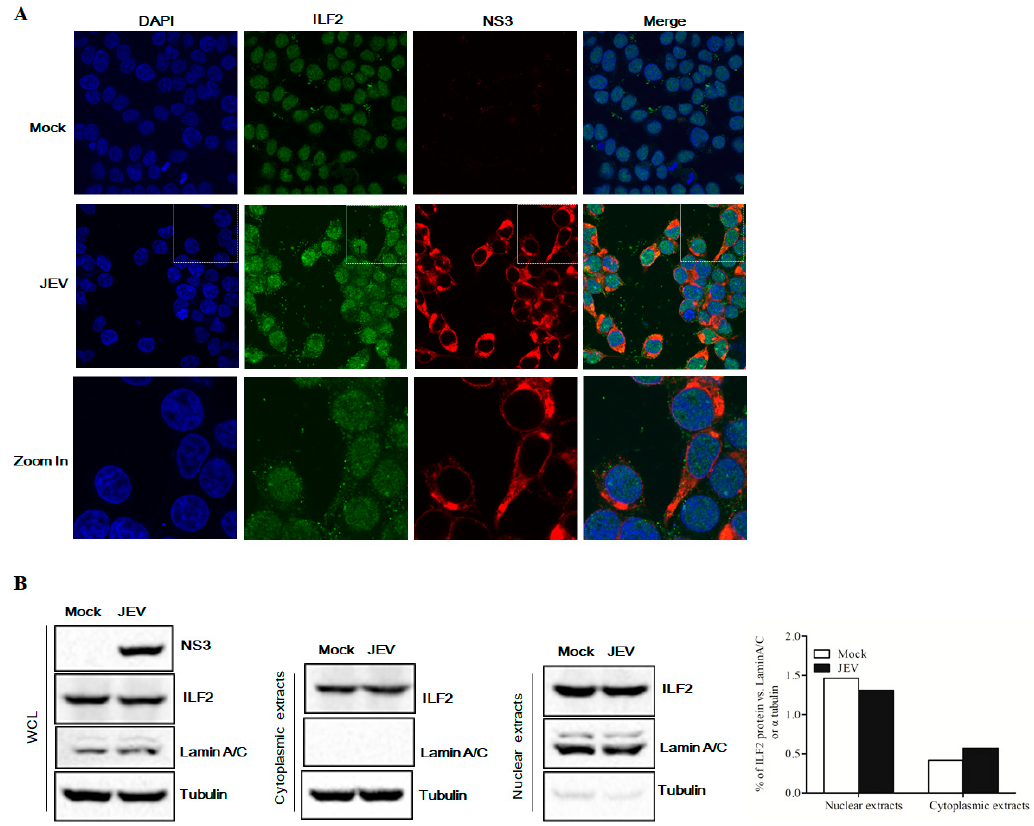
Figure 3. Co-localization of ILF2 with JEV NS3 in virus-infected cells. ( A ) 293T cells were infected with JEV at an MOI of 5 for 24 h, the cells were then fixed with 4% paraformaldehyde and subjected to immunofluorescence assay using anti-ILF2 antibodies (green) and anti-NS3 antibodies (red). The nuclei were stained with DAPI (blue). The images of cells were acquired using confocal microscopy (Carl Zeiss MicroImaging, Inc.). ( B ) Western blot analysis of the distribution of ILF2 in the nuclear and cytoplasmic fractions in 293T cells infected with JEV at an MOI of 1.0. Cell extracts were fractionated at 24 h post-infection (hpi), and JEV NS3 and ILF2 in the nuclear and cytoplasmic fractions were detected by immunoblotting with rabbit anti-NS3 antibodies and rabbit anti-ILF2 antibodies. LaminA / C and α -tubulin were used as nuclear and cytoplasmic markers,